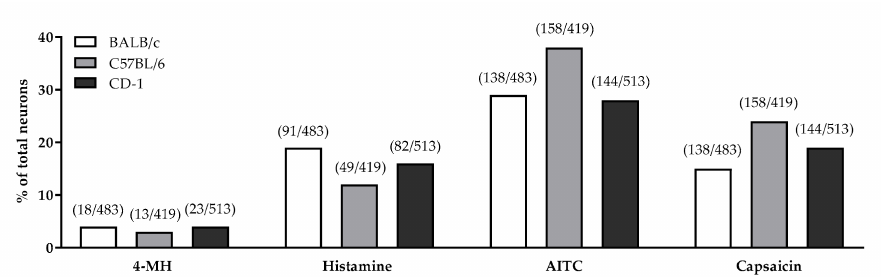
Figure 7. Drug-induced increase in intracellular Ca 2+ (change in 340/380 nm fluorescence intensity ratio) in DRG neurons from BALB/c, C57BL/6 and CD-1 mice in response to 4-MH (100 µ mol/L), histamine (1 mmol/L), AITC (1 µ mol/L), and capsaicin (1 µ mol/L). Total numbers of reactive cells and their percentage of total cell number were examined (KCl 150 mmol/L as positive control).